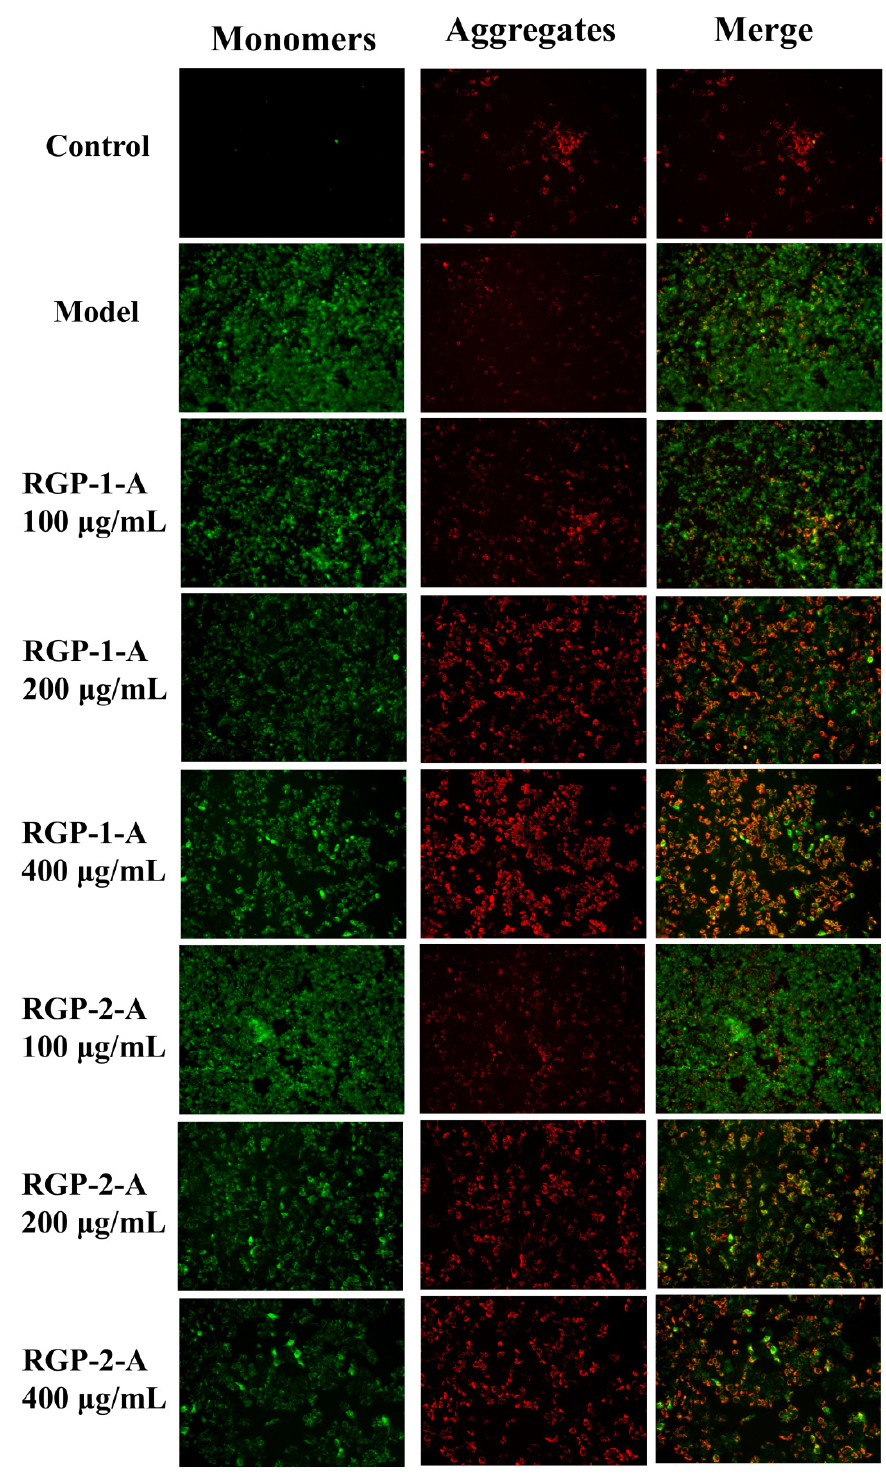
Figure 9. RGPs protected IPEC-1 cells from the H 2 O 2 -induced decrease in mitochondrial membrane potential. IPEC-1 cells were pretreated with 100, 200, or 400 μ g/mL of an RGP for 12 h and incubated with 0.8 mmol/L H 2 O 2 for 8 h. The cells were stained with JC-1, and the morphology of mitochondria was observed using a fluorescence microscope. RGP − 1 − A: Rehmannia glutinosa polysaccharides decolorized by the AB-8 macroporous resin; RGP − 2 − A: Rehmannia glutinosa polysaccharides decolorized by H 2 O 2